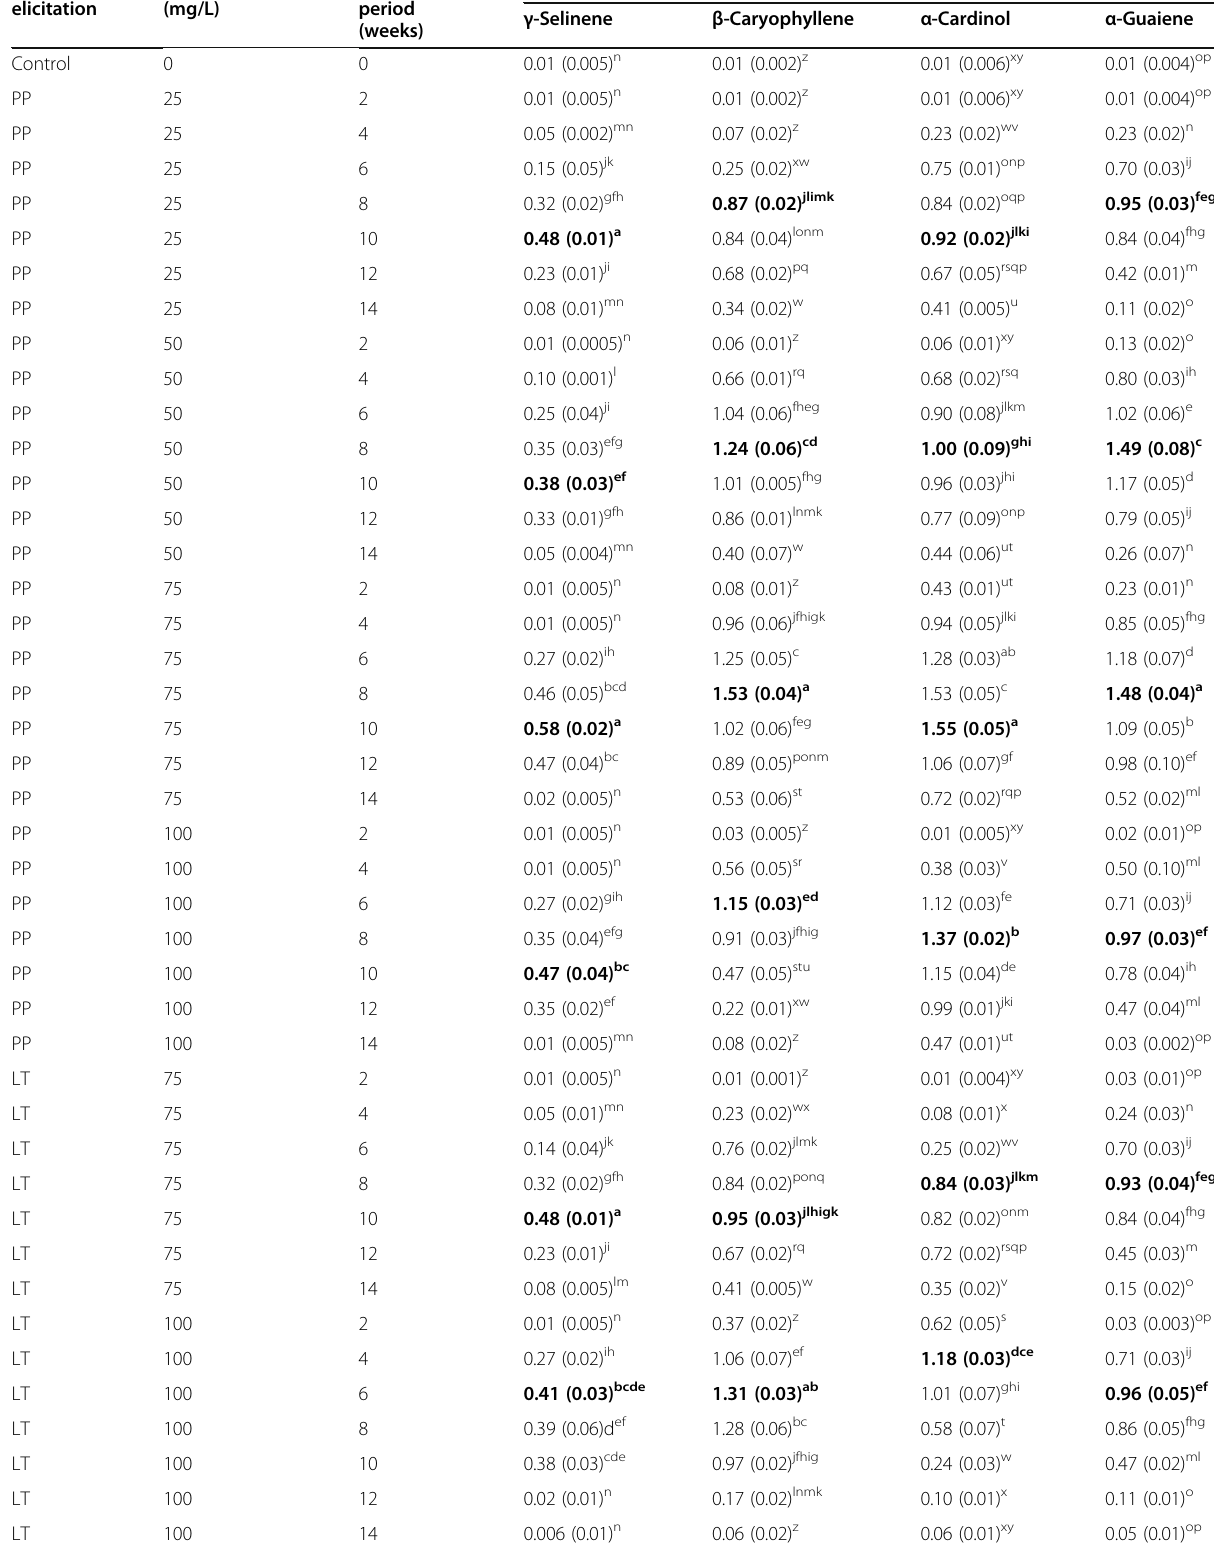
Table 3 Effect of biological elicitors on Gyrinops walla calli Type of